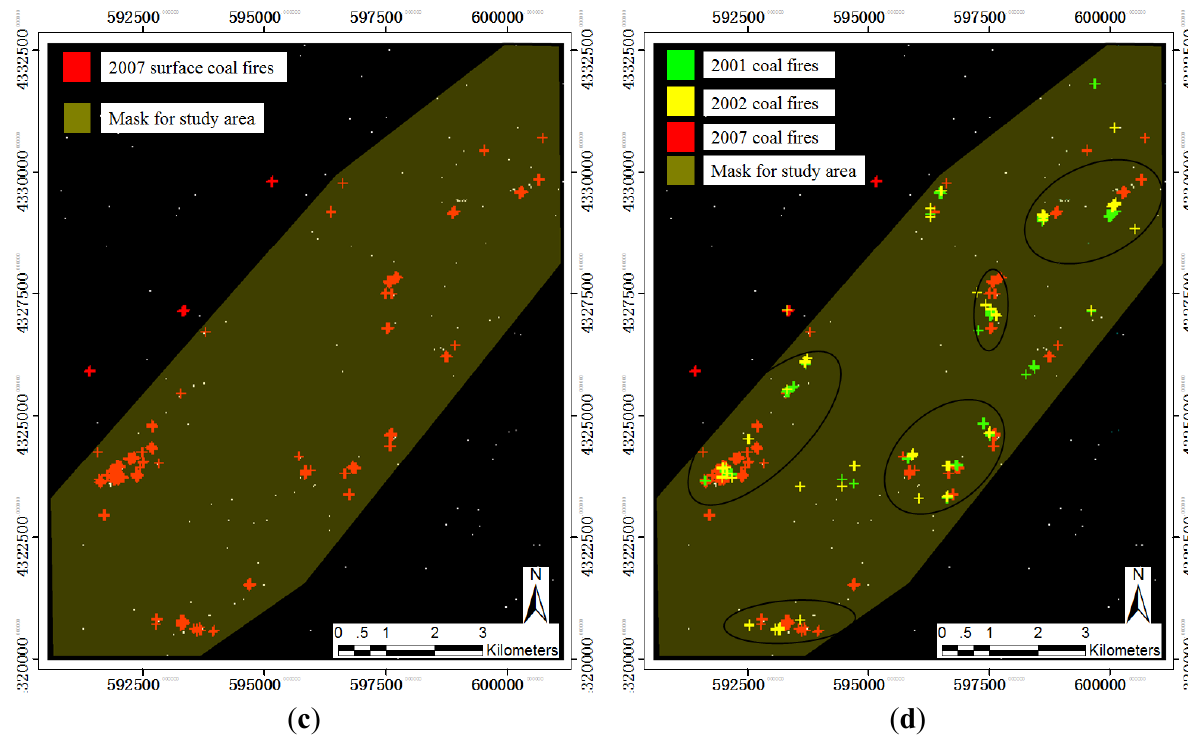
Figure 7. Validation of the results of coal fires extracted from the ETM+ data of 2002 by the field survey coal fire map which was developed during the time range of 2002 to